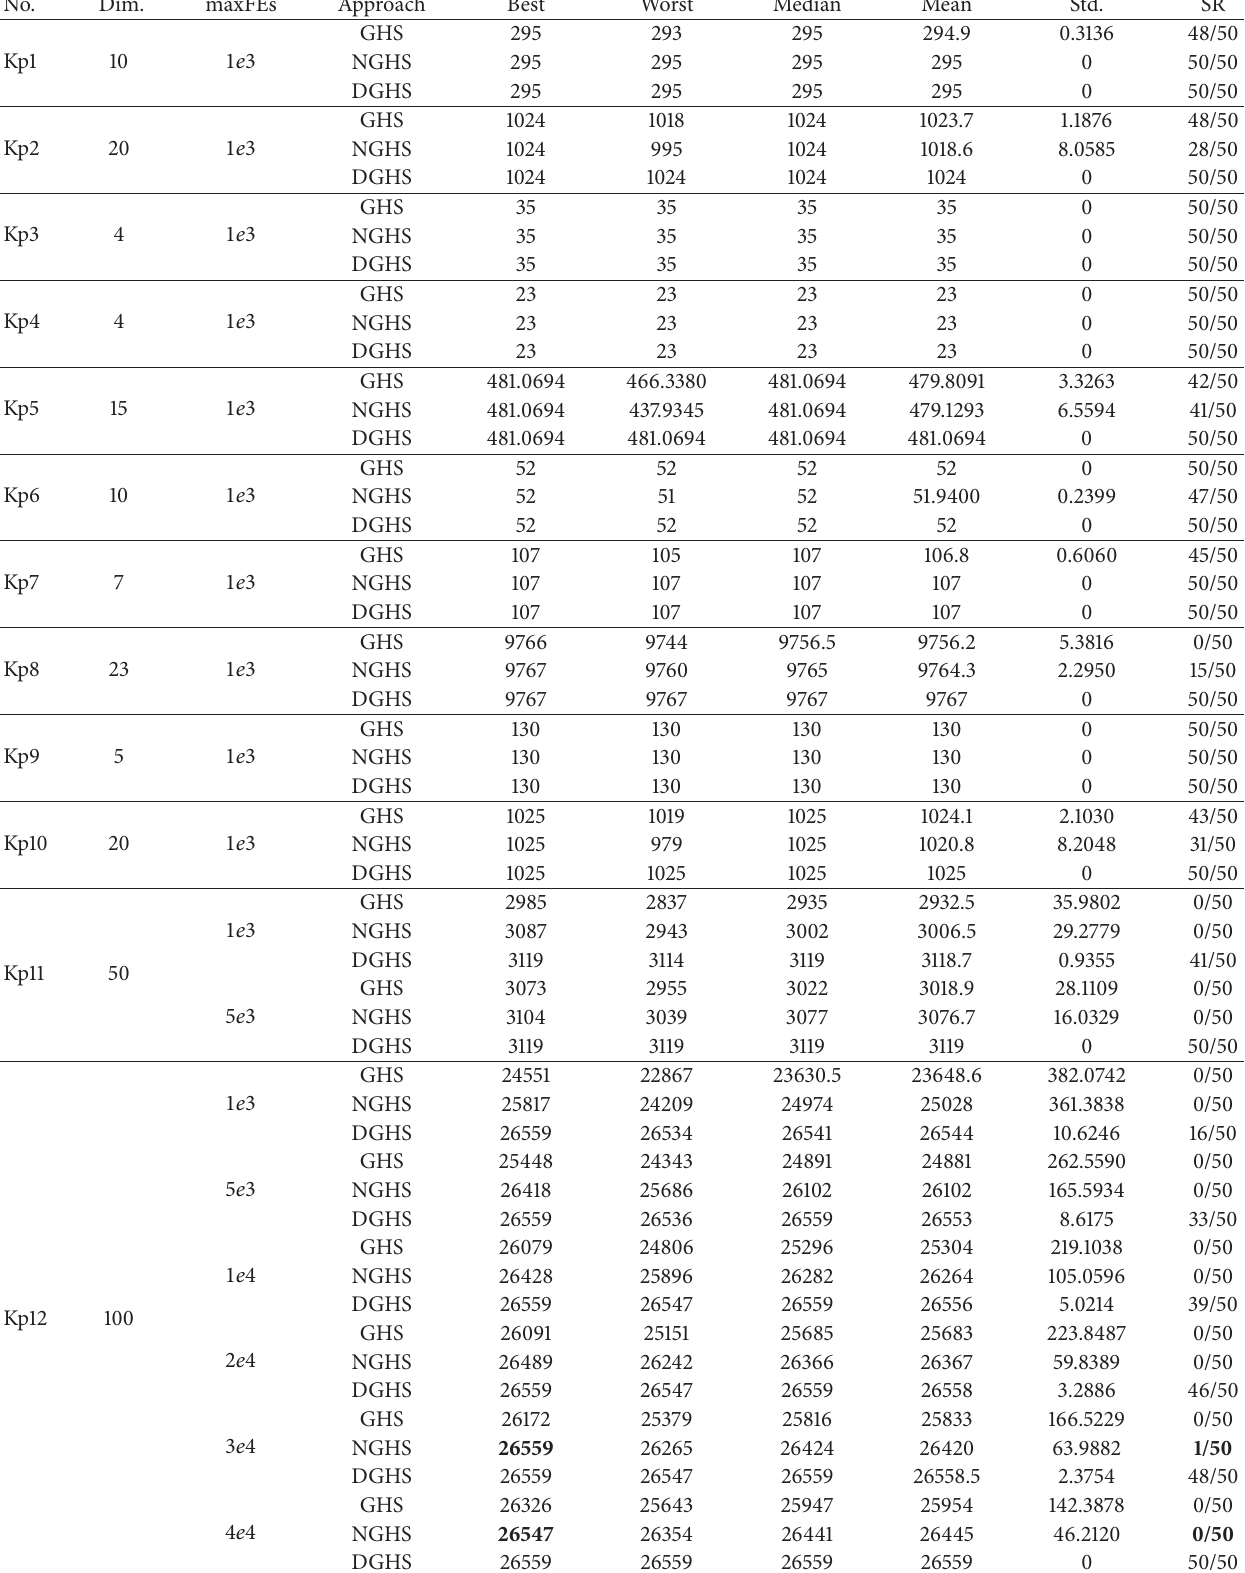
Table 4: Comparison among three algorithms on solving 0-1 knapsack problems with small or median sizes. No.